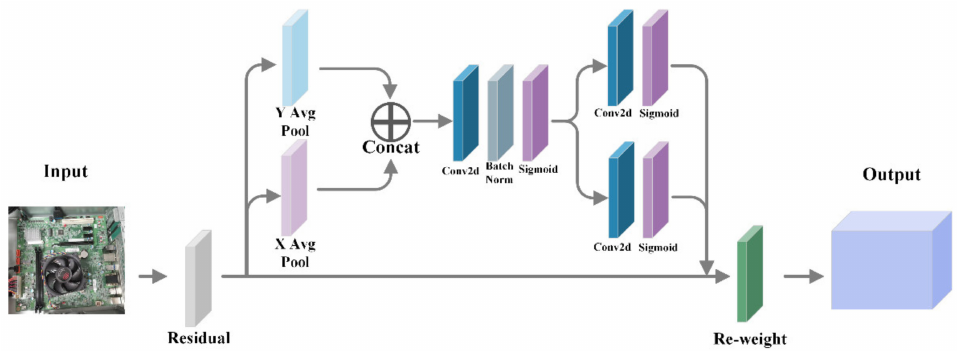
Figure 3. Coordinate Attention